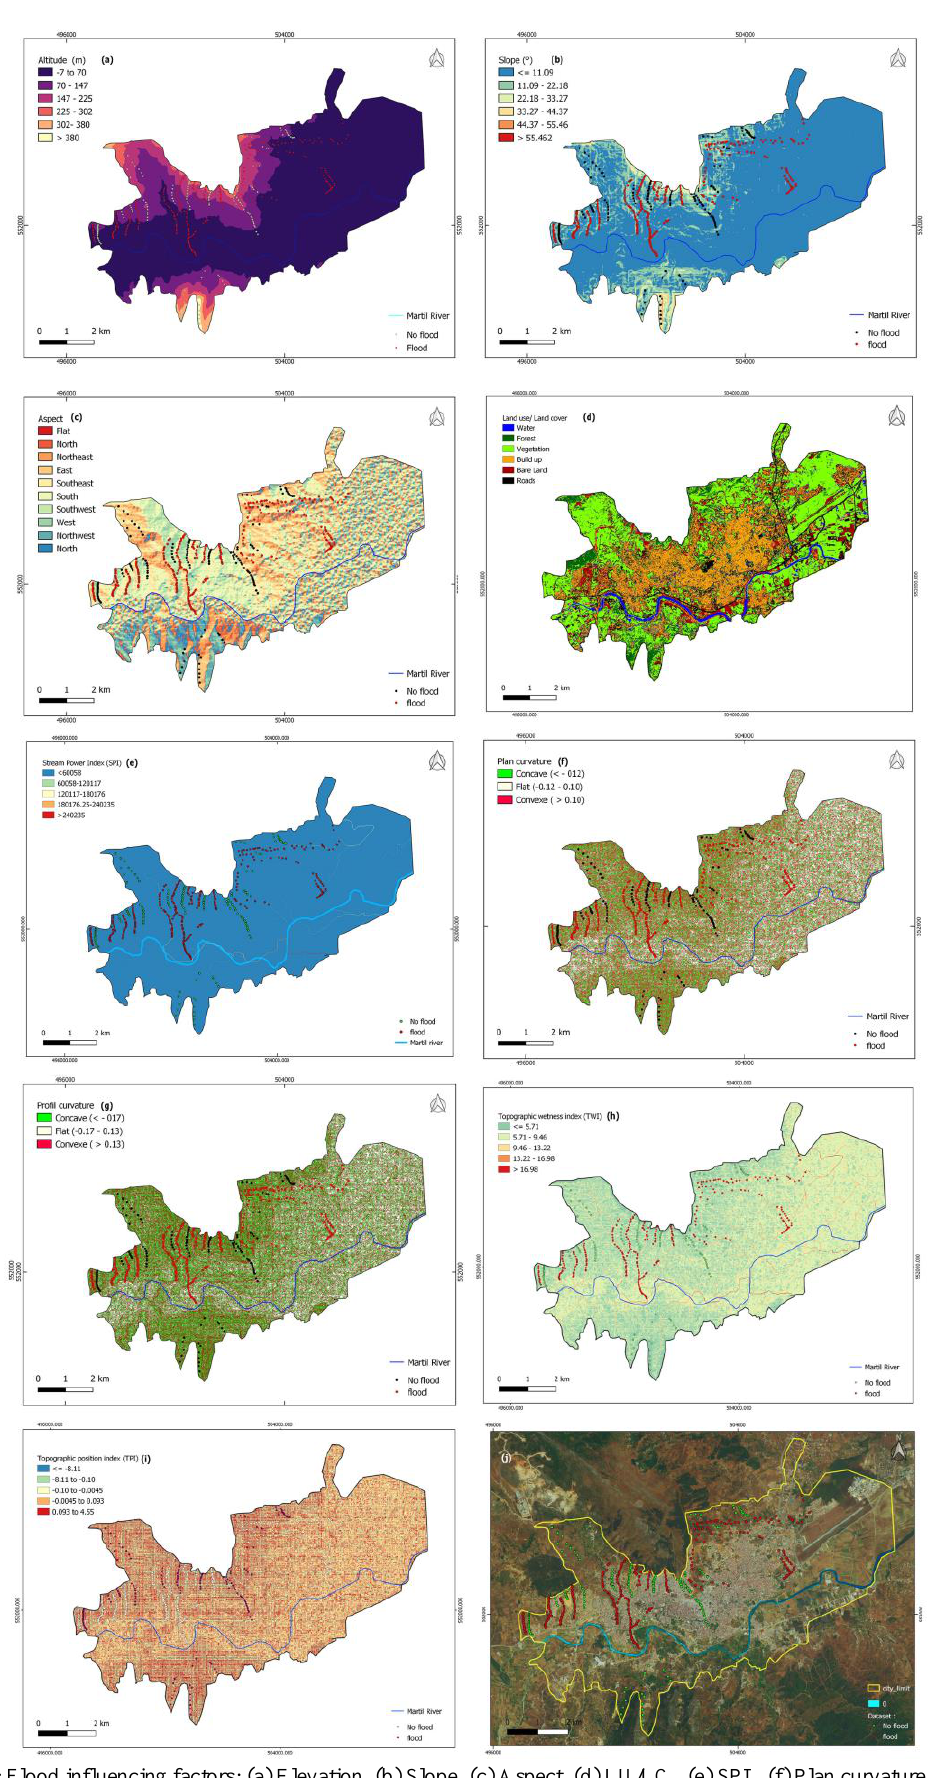
Figure 3 : Flood influencing factors: (a) Elevation, (b) Slope, (c) Aspect, (d) LU/LC , (e) SPI , (f) Plan curvature , (g) Profile Curvature, (h) TPI , (i) TWI and (j) flood and no flood points